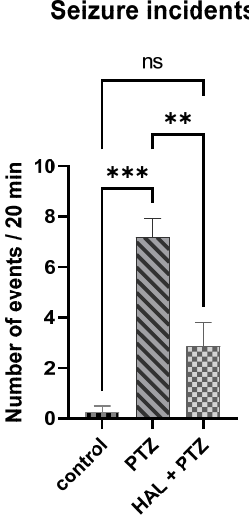
Figure 3. Anticonvulsant activity of halfordin (HAL) and positive control (5 mM sodium valproate, VPN) after 18 h incubation prior to 20 mM pentylenetetrazole (PTZ) treatment (n = 30). Data represent means ± SEM and #### p < 0.0001 vs. vehicle-PTZ control group **** p < 0.0001, ** p < 0.01 * p < 0.05 vs. PTZ-treated group (post-hoc Bonferroni test).